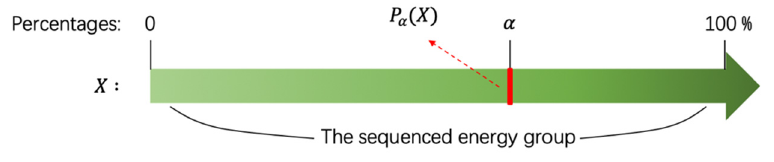
Figure 12. The position function P α ( X ) .